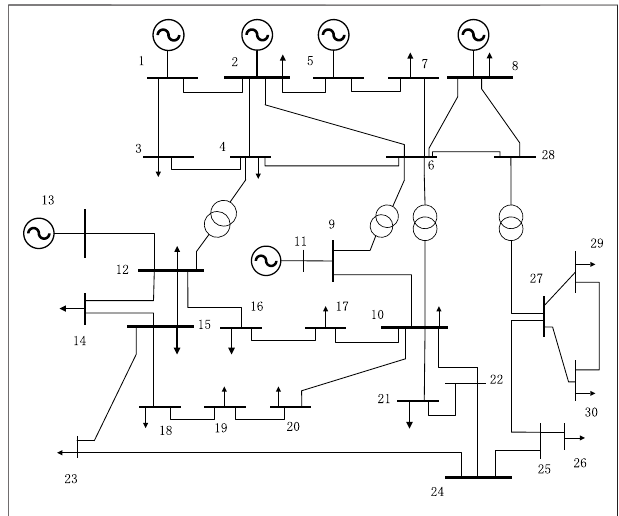
FIGURE 4 | IEEE-30 node power grid system diagram. In the initial stage, the following assumptions are